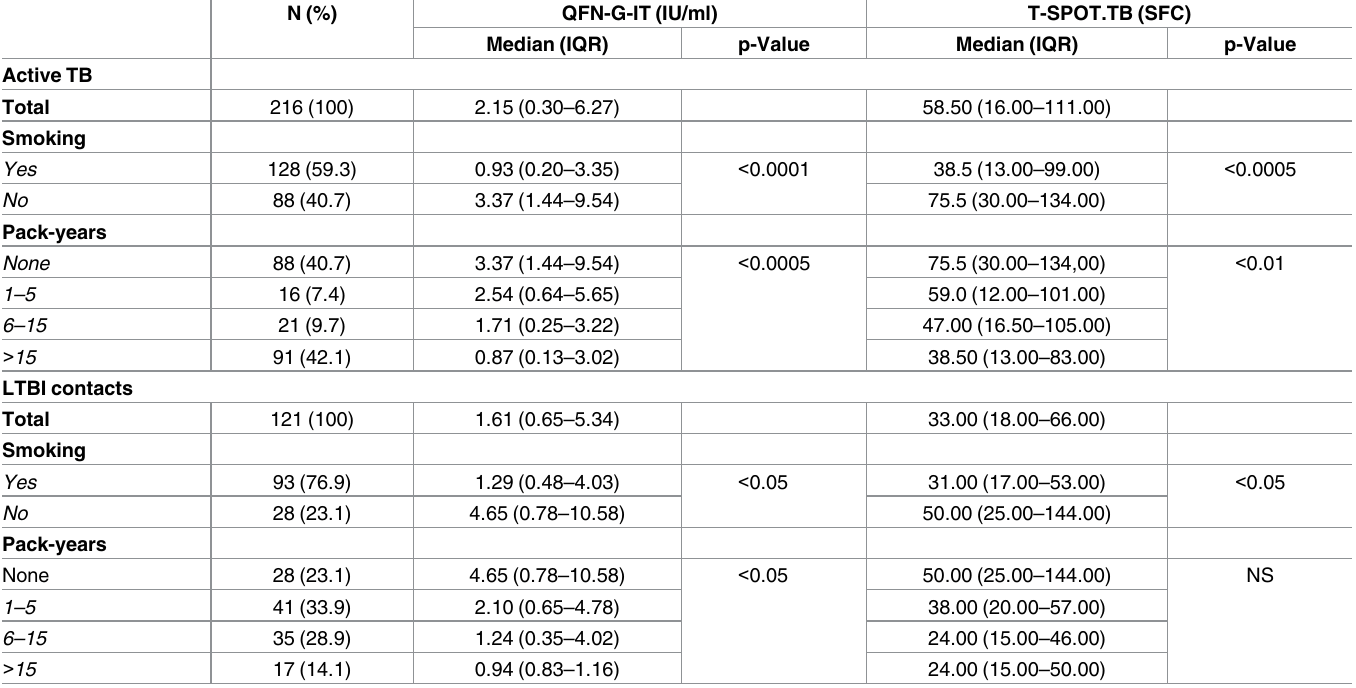
Table 6. Impact of tobacco smoking on Mycobacterium tuberculosis immune